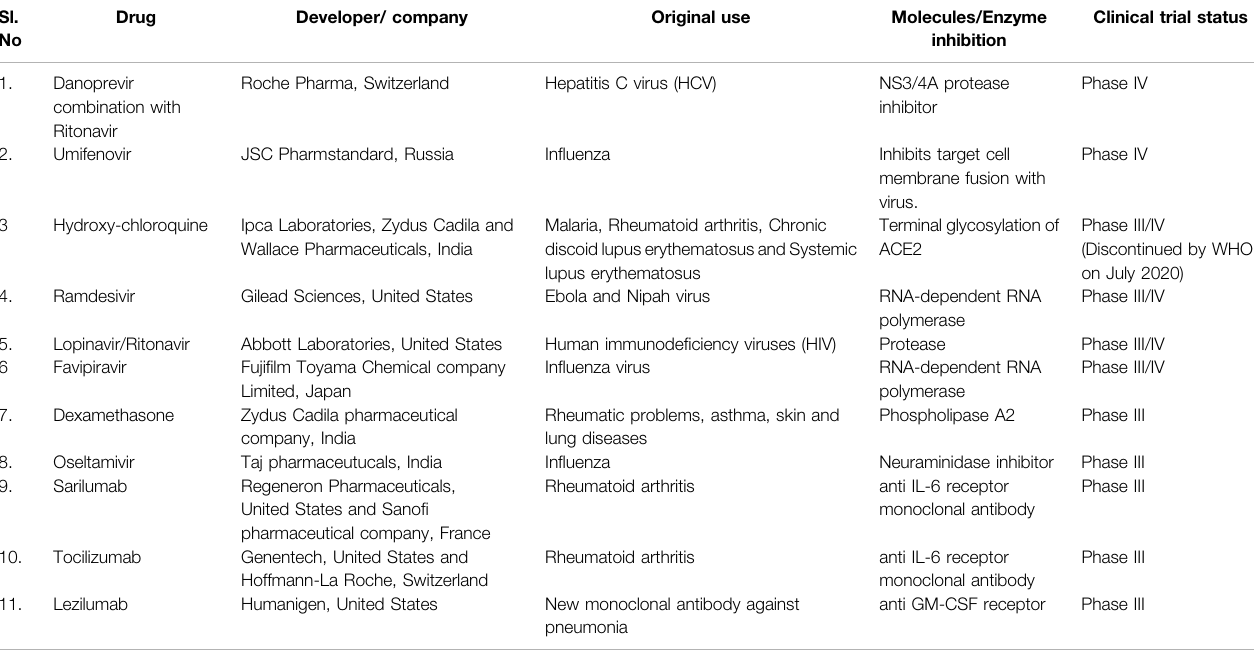
TABLE 1 | Recently approved repurposed drugs for COVID-19